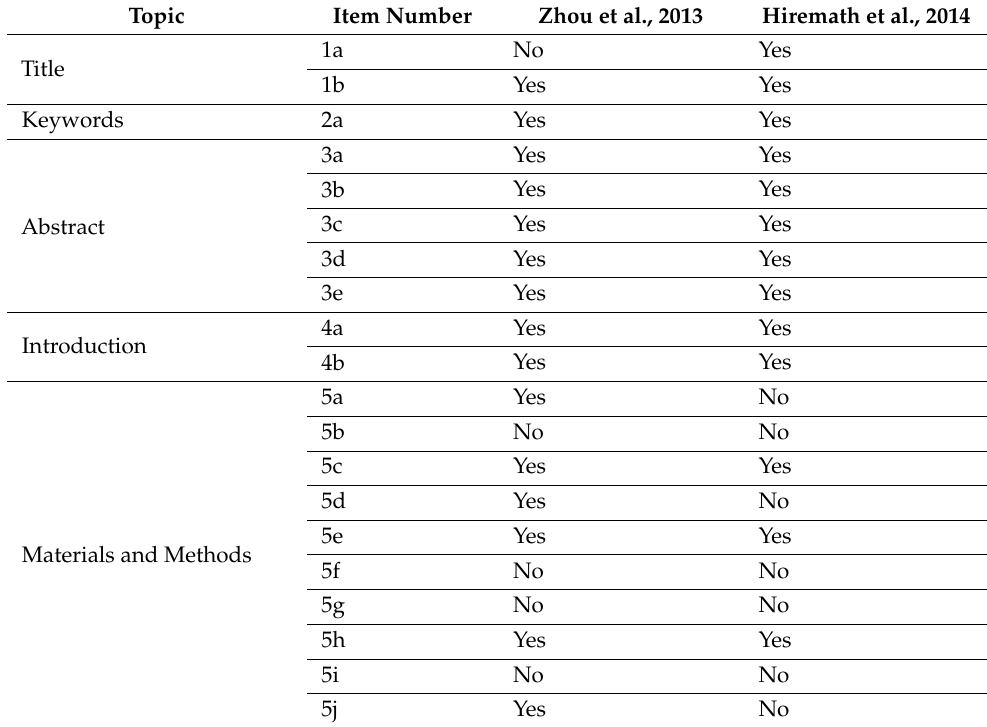
Table 5. Results of the quality assessment of the in vitro experiments reported by the included